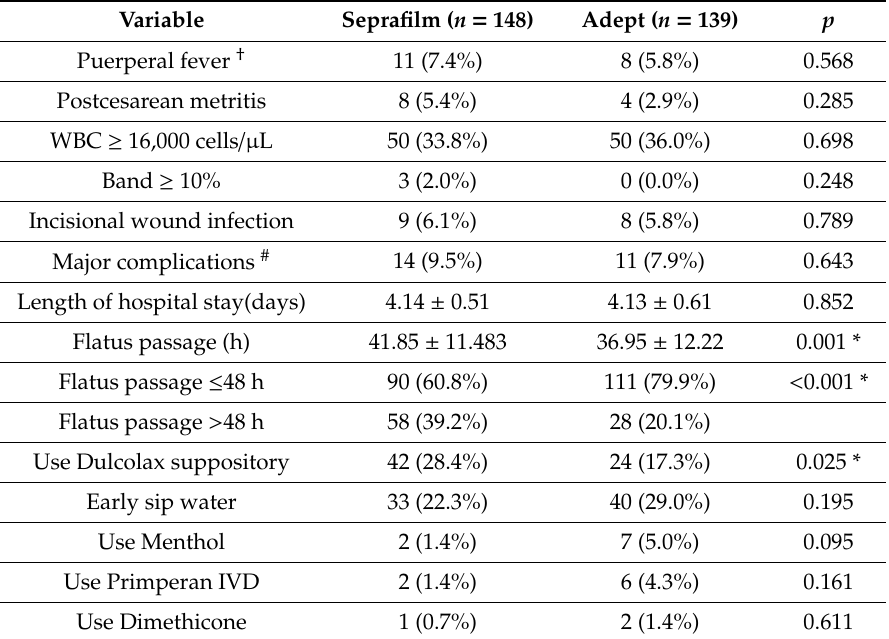
Table 3. Short-term postoperative